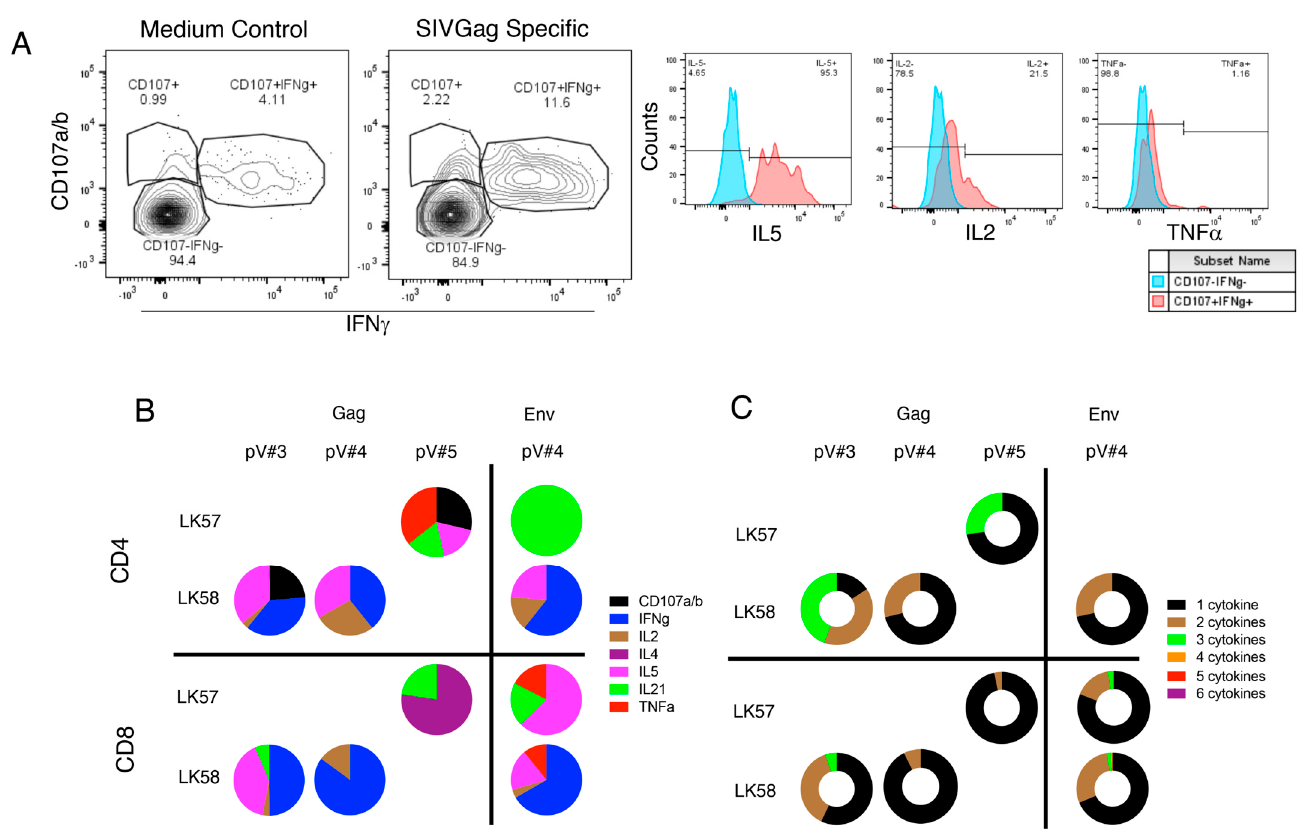
Figure 8. Polyfunctional CD4+ and CD8+ T cell response to vaccine antigens in jejunum lymphocytes from vaccinated protected (VP) macaques. Jejunum lamina propria lymphocytes (LPL) were isolated at two weeks post vaccination (pV) time points including pV#3, pV#4, and pV#5, and were stimulated with overlapping Gag and Env peptide pools. Following stimulation, cells were stained for the presence of CD107a/b, IFN γ , IL2, IL4, IL21 and TNF α . ( A ) Representative contour plots of jejunum LPL CD4+ T cells showing CD107a/b and IFN γ expression in presence of SIVGag peptides compared to medium control from a vaccine protected LK58 macaque. The frequency of each subset is shown in the box of each gated plots. The jejunum CD107a/b- IFN γ - CD4+ T cells (blue histograms) and CD107a/b+ IFN γ + CD4+ T cells (red histograms) were further analyzed for expression of IL5, IL2 and TNF α . Percentages of positive and negative population for each cytokine for CD107a/b+ IFN γ + CD4+ T cells are shown at the top of each histogram. ( B ) Each segment of the pie represents the proportion of different cytokines produced by either CD4 or CD8 T cells in presence of SIV antigens. ( C ) Each segment of the donut represents the proportion of CD4+ or CD8+ T cells secreting the combination of multiple cytokines.